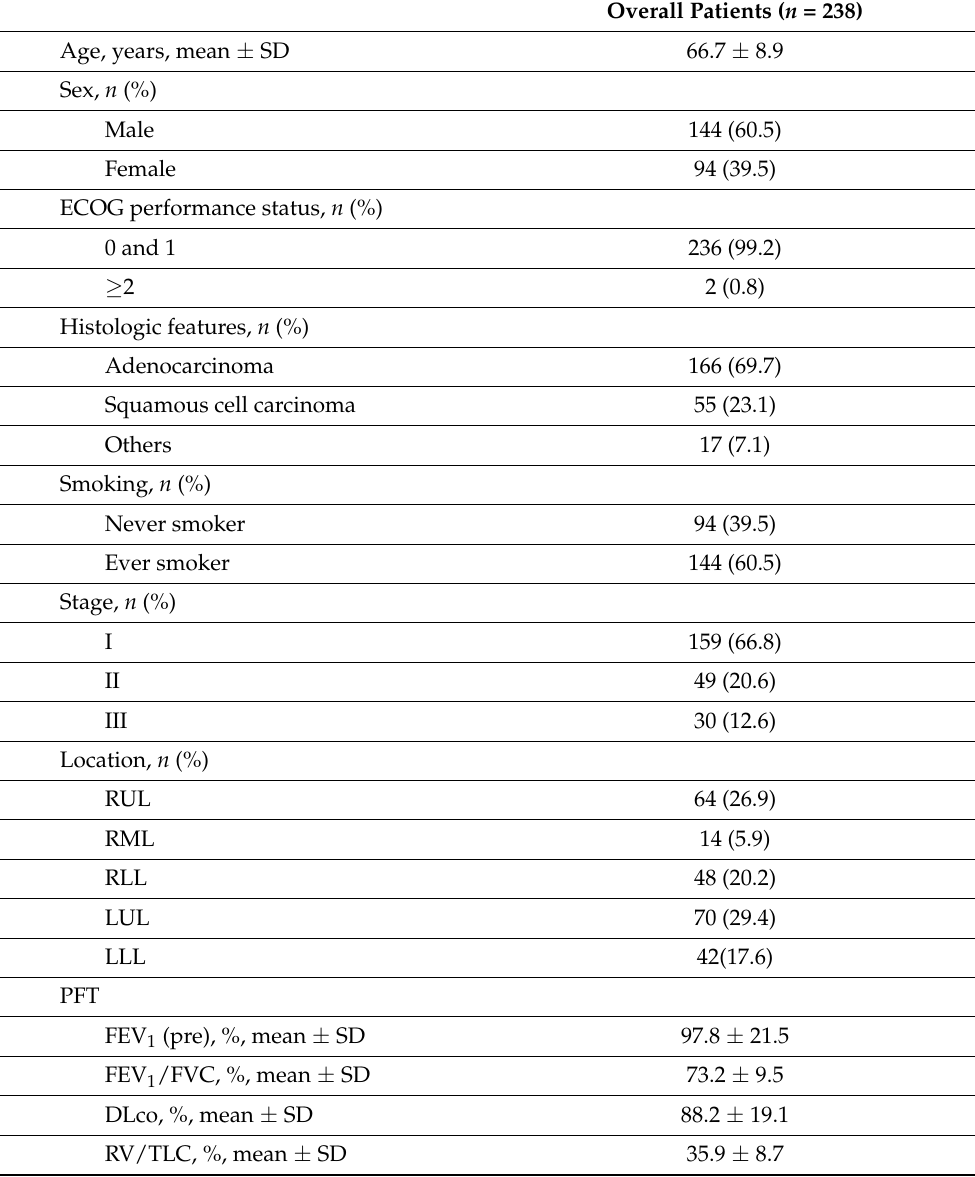
Table 1. Clinical characteristics of the study